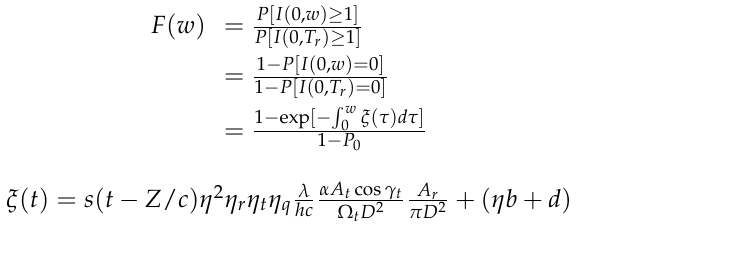
Figure 2. Relationship between the position errors and the spacing of the receiving subsystems. ( a ) The error in the direction of the x -axis. ( b ) Error in the direction of the y -axis. ( c ) Error in the direction of the z -axis. ( d ) Magnitude of the errors. When the target enters the region of interest, its spatial position can be calculated to provide information for target tracking. Like all lidars, it needs to be used together with other systems. The target situation can be known according to the prior information of other systems. When the targets are in dense formation flight, the targets can be regarded as one. The distances measured by different collecting ports are separated by the time coding method, and then the multiple range echoes measured by each collecting port are averaged. According to the averaged distances, the space position of the “one target” can be calculated. After obtaining the approximate center position coordinates of the targets, this information can be provided to other systems as a priori for further processing. When the targets’ spacing is large and the targets pass through the detection area one by one, the target position can be calculated separately. The detector needs a larger detection field of view to ensure that the overlapping area meets the needs of the detection target, result- ing in large background noise. This problem can be solved by adding filters, changing the laser wavelength, etc. As shown in Figure 1b, M represents the target, and A , B , and C are the spatial distribution positions of three optical fibers (simplified receiving subsystems), respec-